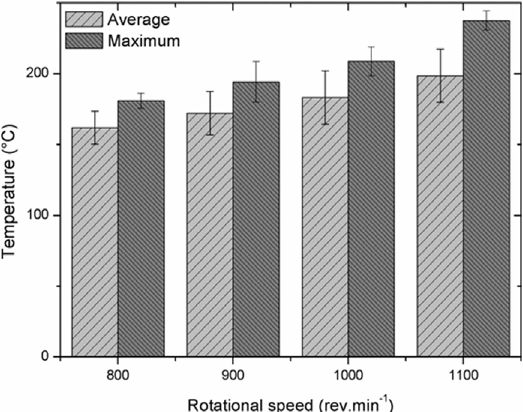
Figure 5. Temperature measured for the different tested conditions: maximum registered peaks and peak averages obtained from the eight sensors.